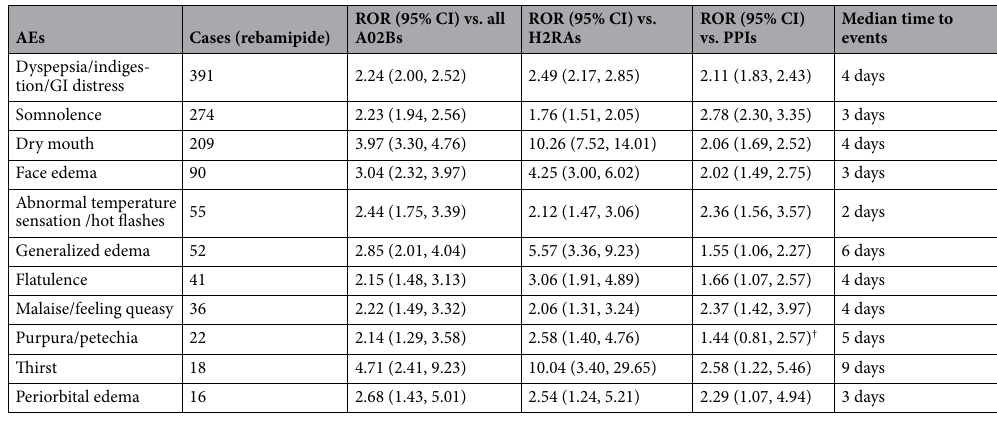
Table 3. Frequently reported AEs in the elderly population. AE adverse event, CI confidence interval, GI gastrointestinal, H2RA histamine 2 receptor antagonist, PPI proton pump inhibitor, ROR reporting odds ratio. † Not